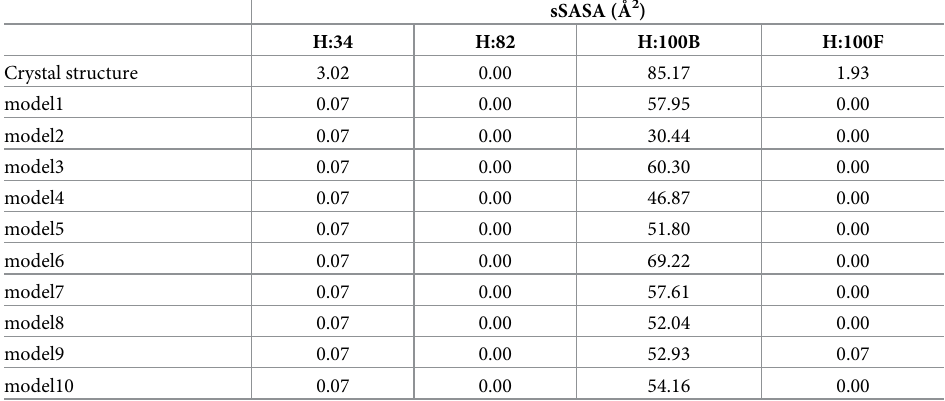
Table 3. Solvent-accessible surface area (SASA) of the side chain of the methionines in the Fv region of Vesencumab.